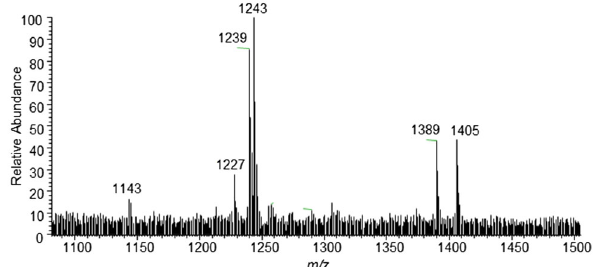
Fig. 1 Full scan DFI-ESI-IT-MS n (Negative Ionization) mass spec- trum of Luidia senegalensis showing the peaks corresponding to the saponins